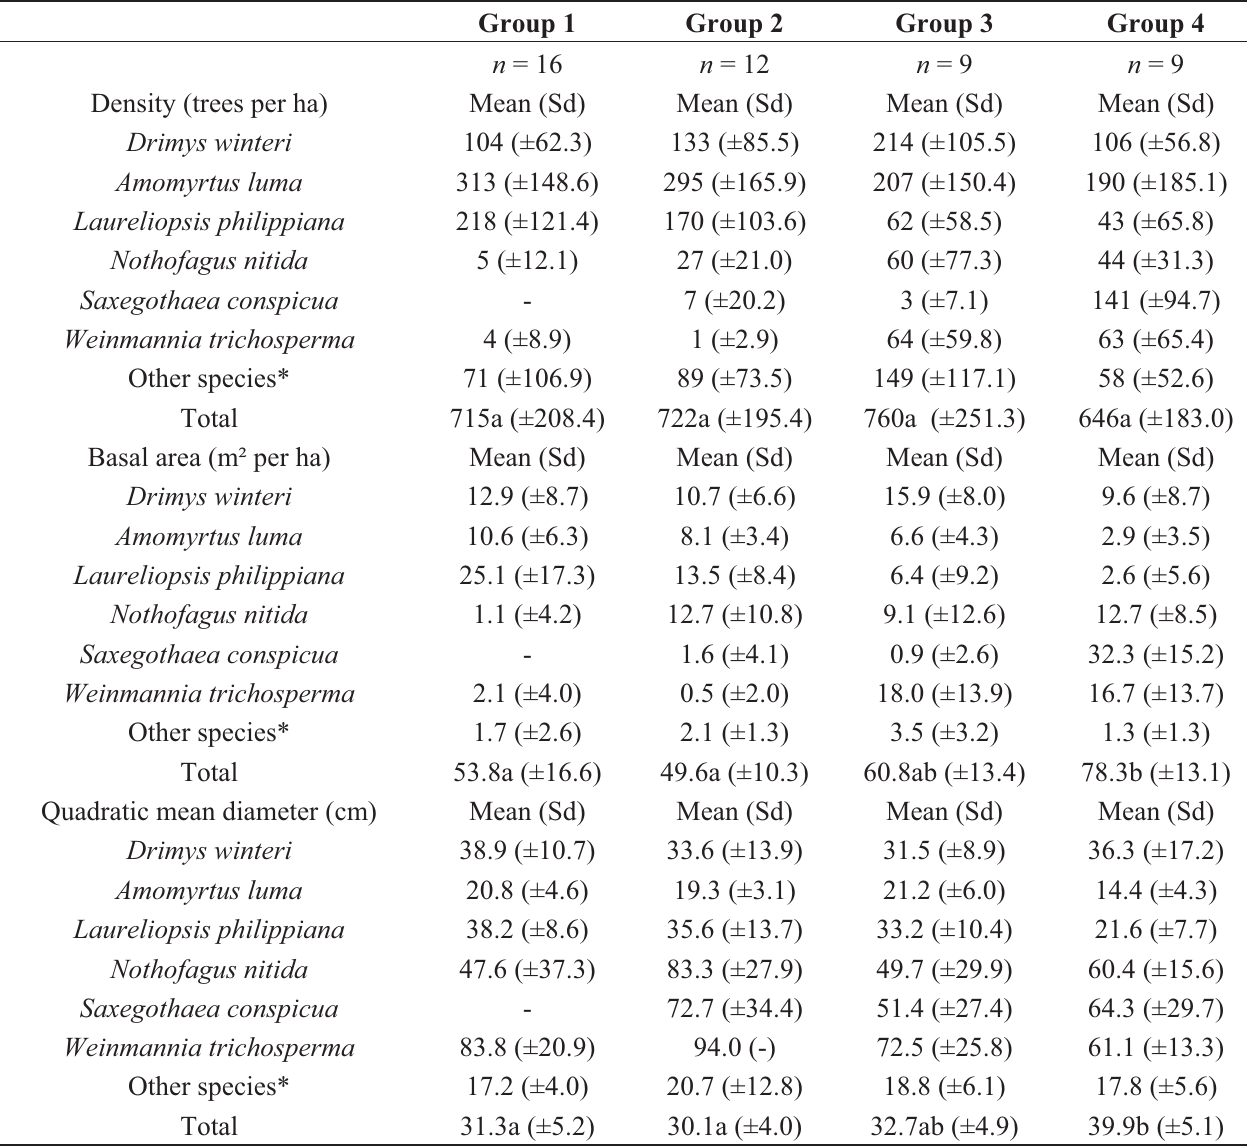
Table 2. Mean values and standard deviations ( Sd ) for density, basal area and quadratic mean diameter for each species and forest